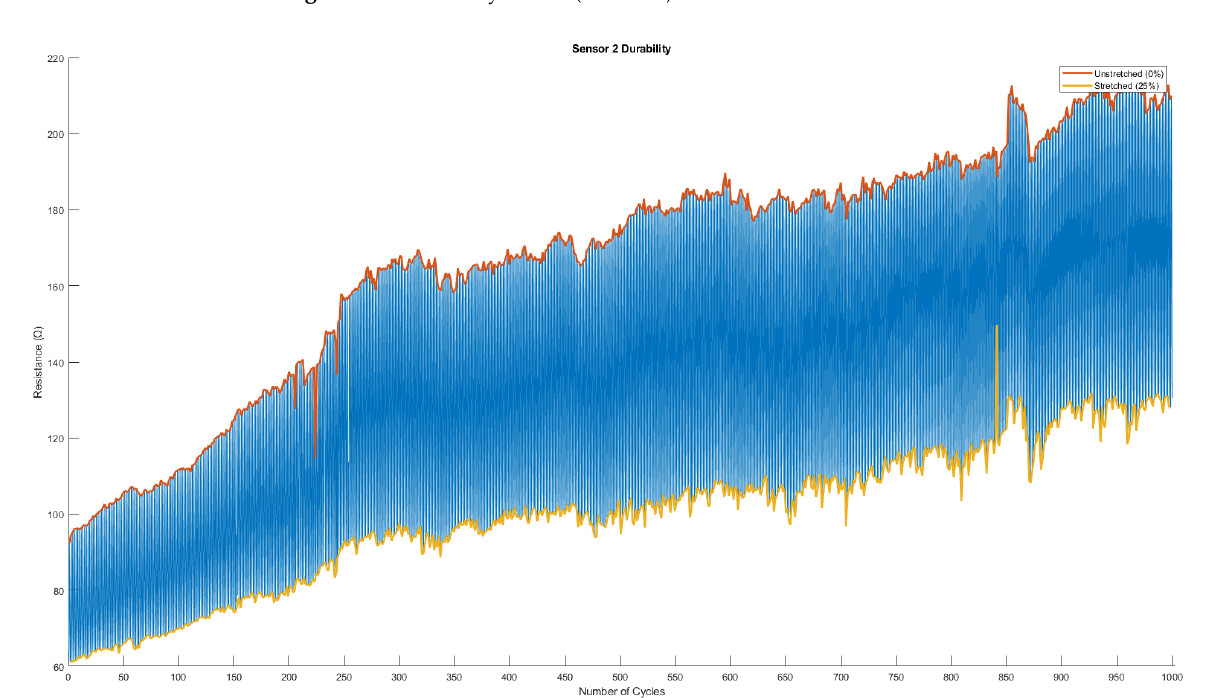
Figure A2. Durability Result